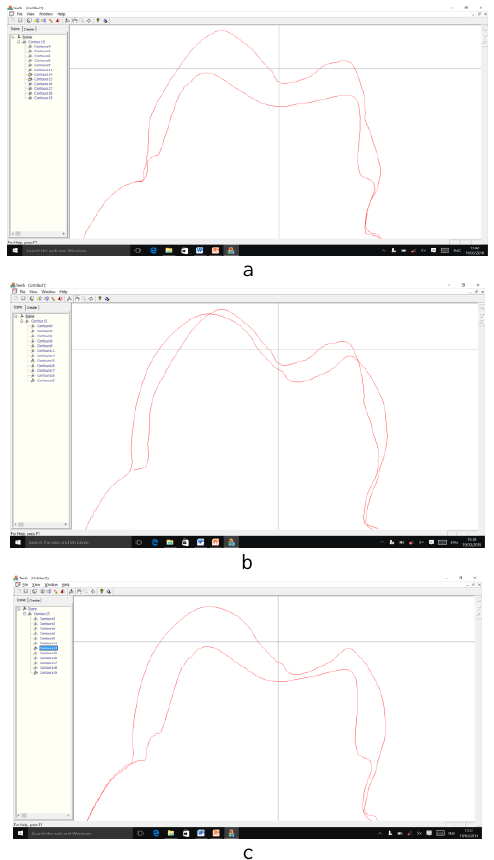
Figure 12. Combined contours for automated feature detection: a – intact tooth/prepared tooth; b – intact tooth/crown; c –